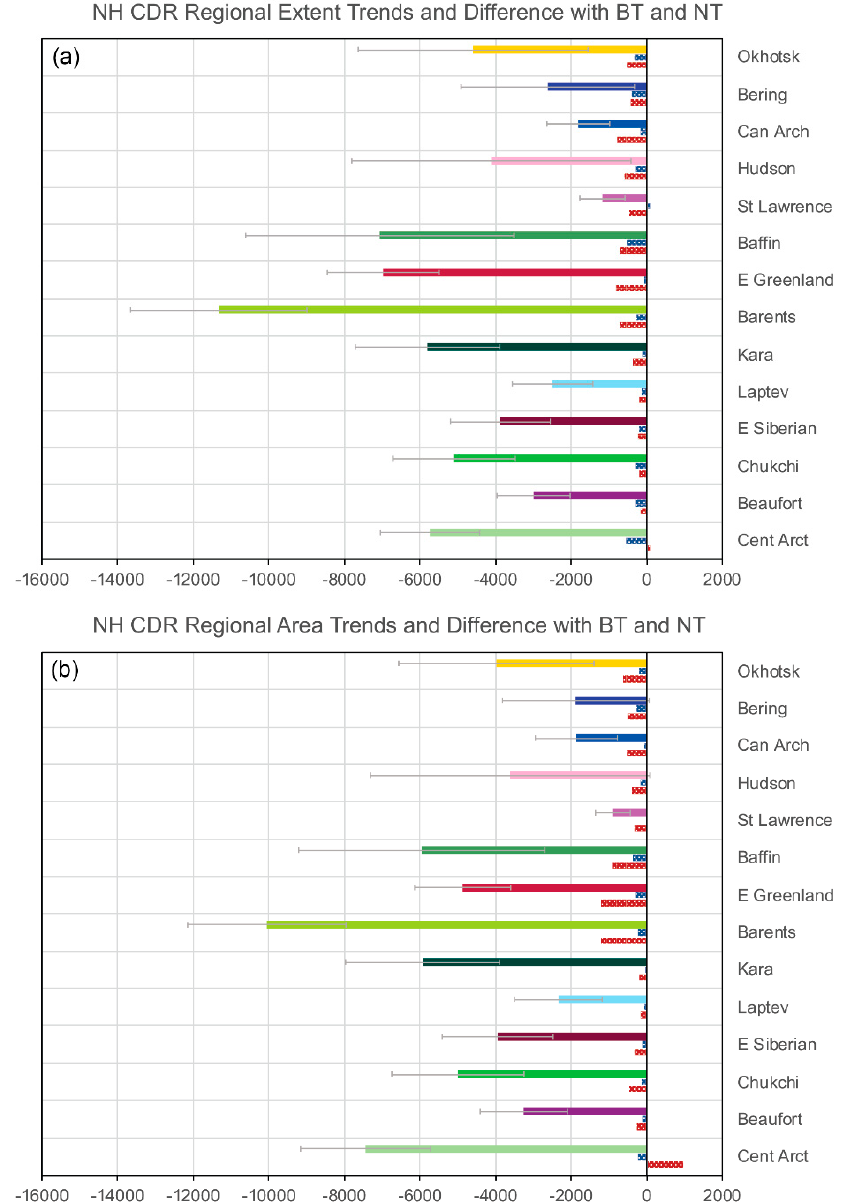
Figure 6. Northern Hemisphere regional ( a ) extent and ( b ) area trends in km 2 yr − 1 . Solid color bars correspond to the region colors in Figure 5. The gray error bars represent the 2 standard deviation range of the linear trend fit. The blue hatched bar for each region indicates the CDR–BT trend and the red hatched bar indicates the CDR–NT trend.